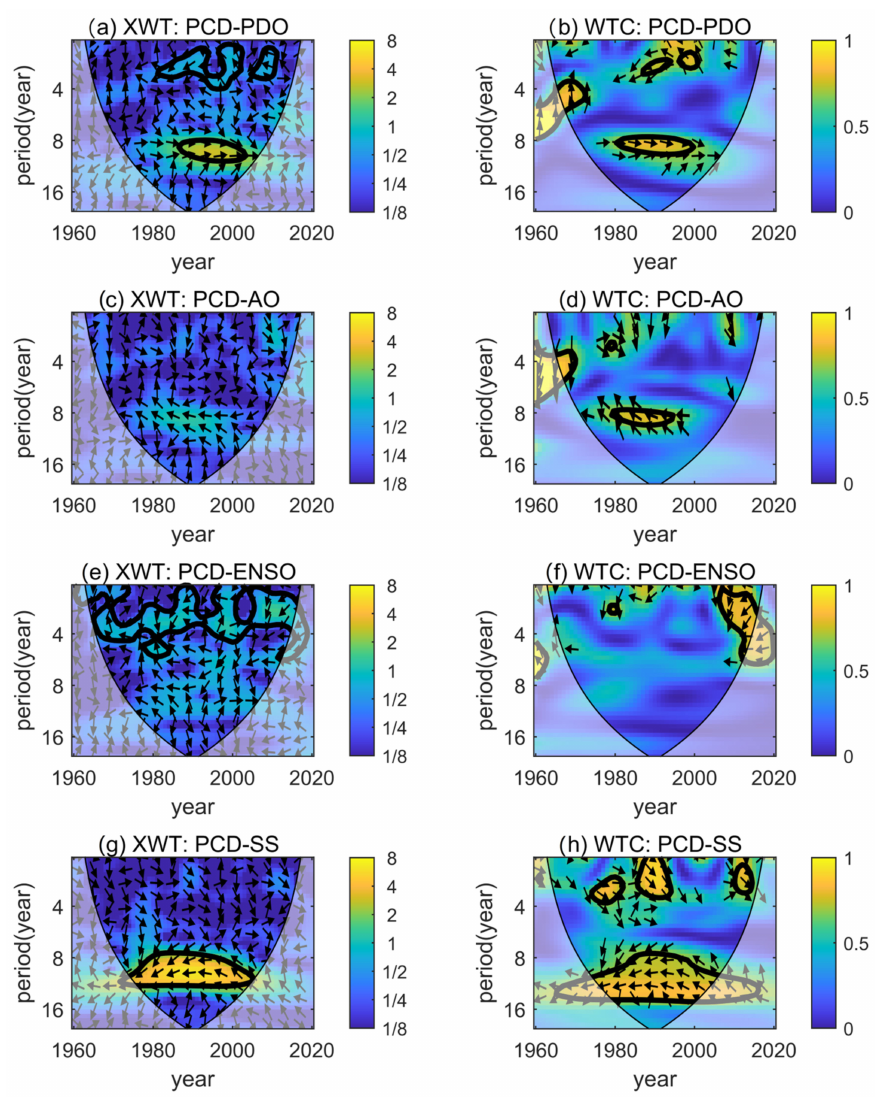
Figure 4. CWT spectrum between PCD and PDO/AO/ENSO/SS. ( a , c , e , g ) show the results of XWT; ( b , d , f , h ) show the results of